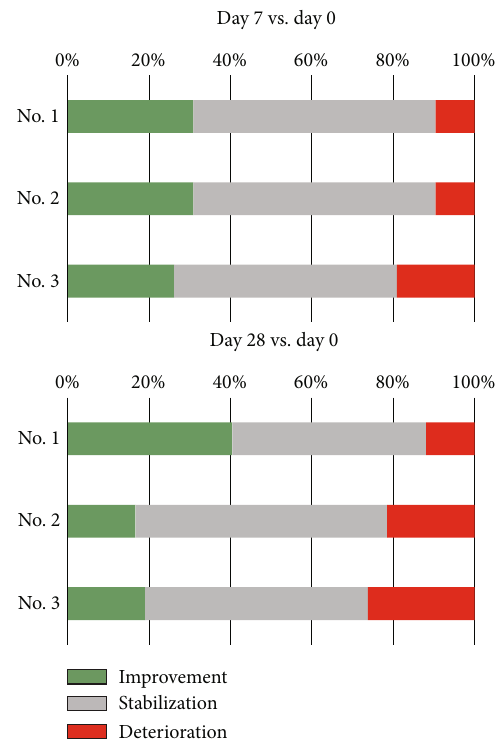
Figure 3: Subjective VHI questionnaire results after 7 and 28 days post each injection of Lin − cells (No. 1, No. 2, and No. 3) compared to the baseline values (day 0 of each procedure). Colors represent the percentage of patients ( n = 42 ) in which the analyzed parameter improved (green), remained stable (gray), or deteriorated